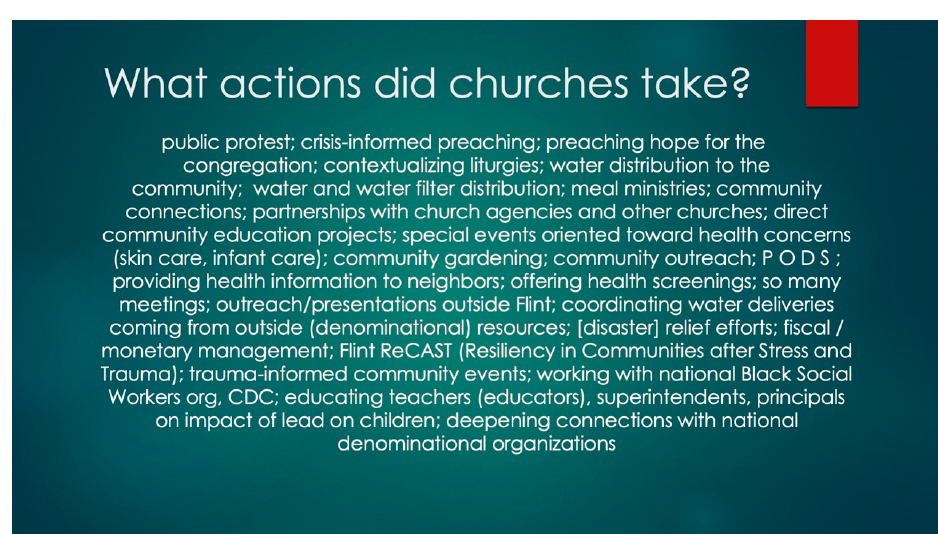
Figure 1. Actions: an image of the list of actions taken by Flint faith leaders.